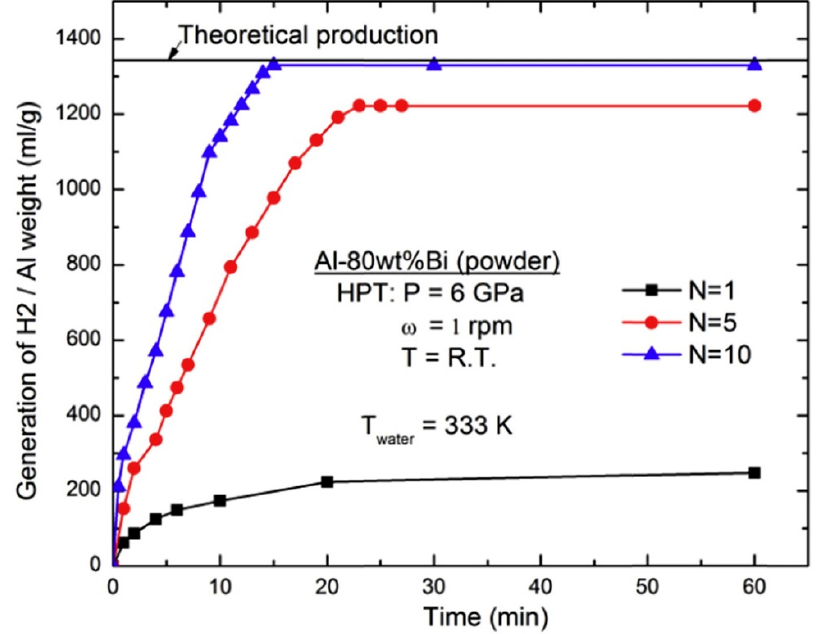
Figure 12. Hydrogen generation against time for Al-80 wt.% Bi alloy processed by HPT with different number of revolutions (N = 1, 5, 10) [135].